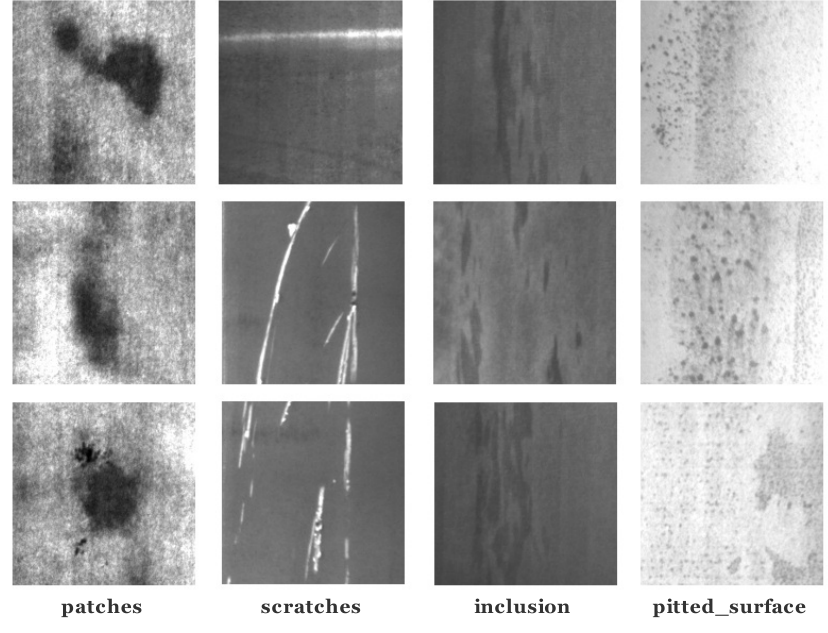
Figure 4. Some images selected by our active learning